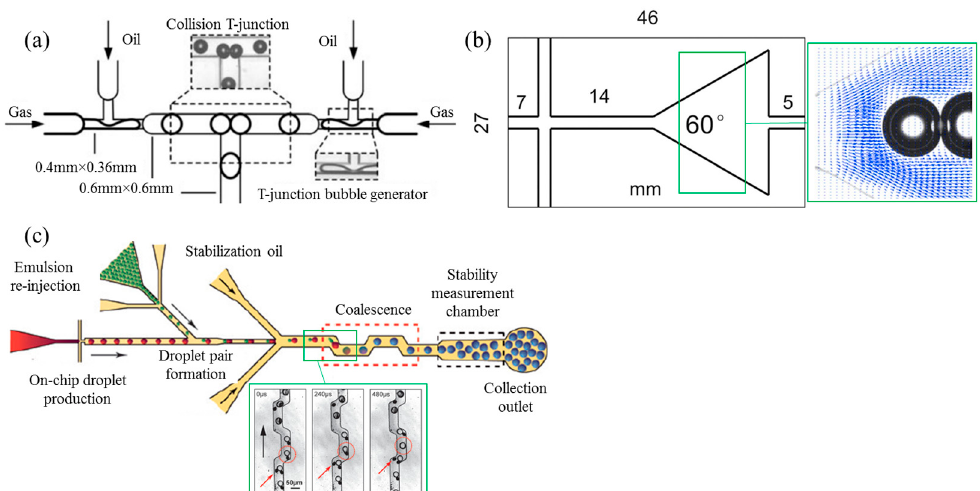
Figure 8. ( a ) Microfluidic system for 1-on-1 bubble interaction, reprinted from Yang et al. (2009) [66]. ( b ) Microfluidic expansion device and the velocity field (obtained by the micro Particle Image Velocimetry technique, micro-PIV) around the aligned bubbles, reprinted and adapted from Fu et al. (2015) [67] with permission from Elsevier. ( c ) Droplet fusion device, consisting of a droplet generation junction, a coalescence channel and a detection unit, for the assessment of coalescence stability; reproduced and adapted from Mazutis et al. (2012) [68] by permission from the Royal Society of Chemistry.